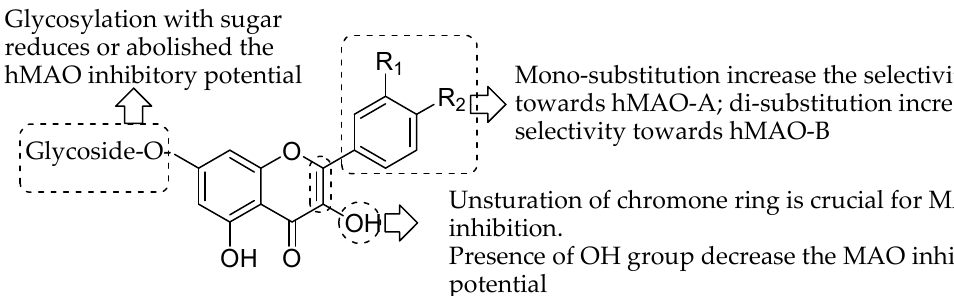
Figure 19. Structure-activity relationships (SAR) trends inferred from the data of enzymatic and docking experiments reported above.